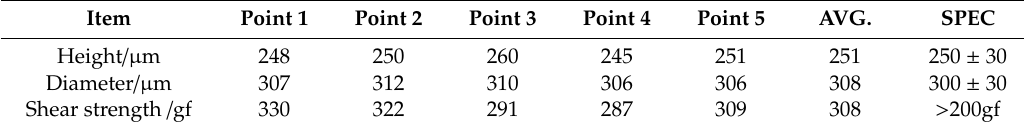
Figure 18. OM image and cross-section SEM image of the solder ball. Table 10. The ball height, ball diameter and ball shear strength of solder ball in BGA process.